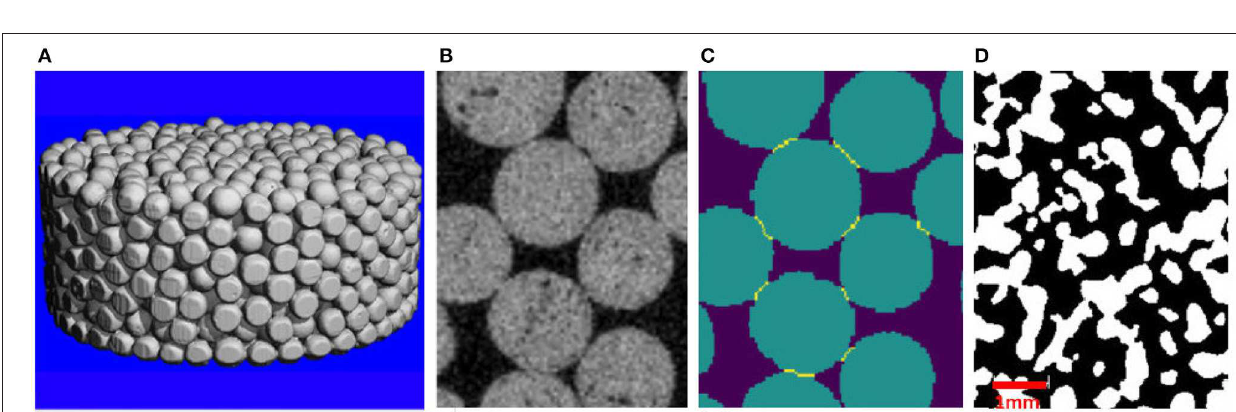
FIGURE 2 | Microscopy images of exemplary particles of nature identical snow (A) and ice beads (B) , same scale (mm) in both images. (C) Sample of unconfined sintered ice beads, after removal of sample holder wall, before compression test.